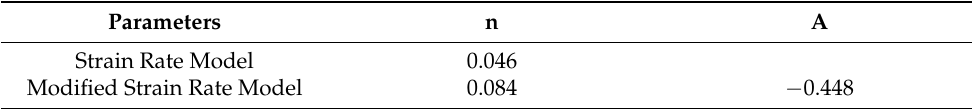
Table 8. Parameters of strain rate models in this paper.